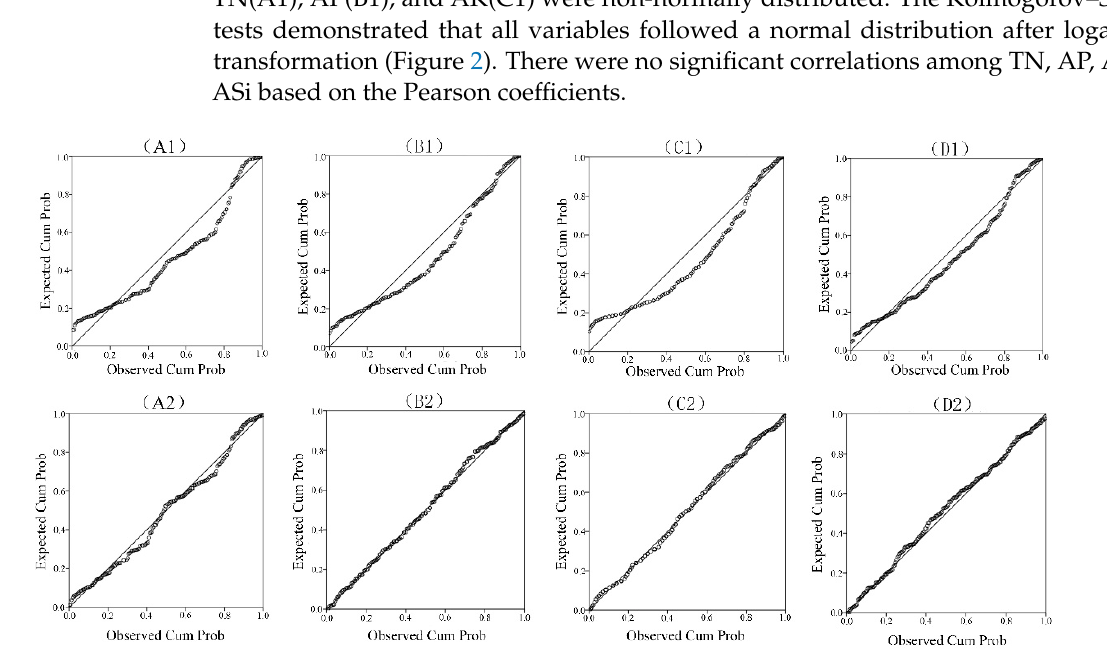
Figure 2. Maps of normal P-P Plot (probabilty probabilty plot). The upper picture ( A1 , B1 , C1 , D1 ) shows the data distribution before transformation; the lower picture ( A2 , B2 , C2 , D2 ) shows the data distribution after logarithmic transformation.